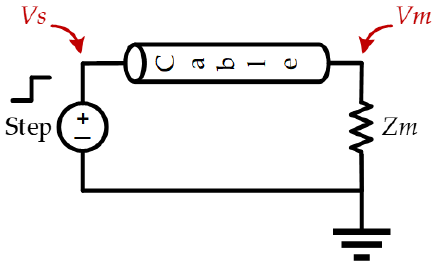
Figure 2. Simplified motor considered as one lumped resistance connected to a step voltage source through a cable.